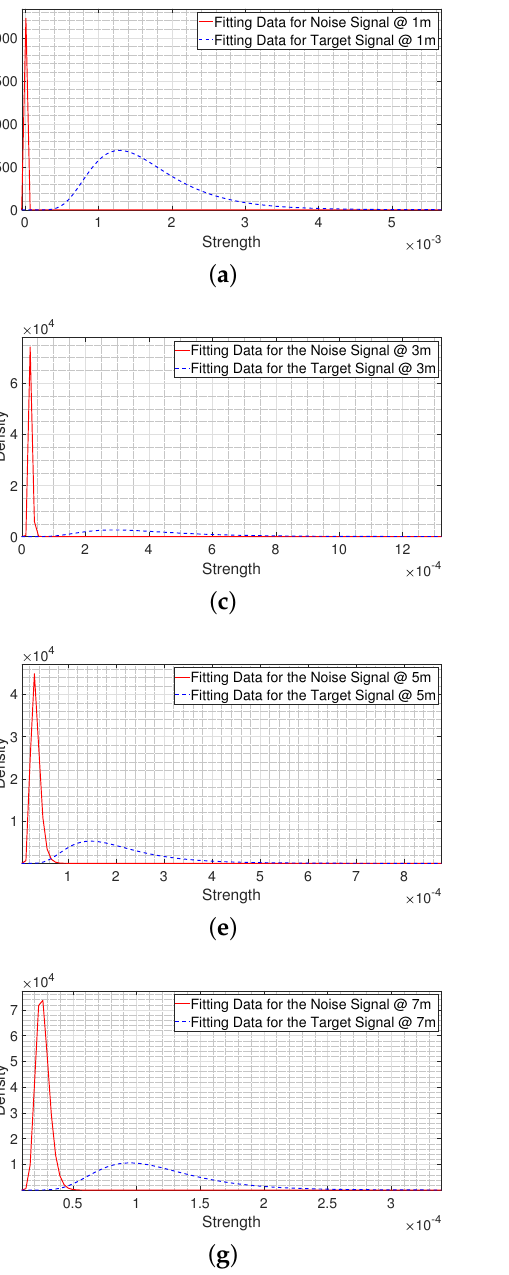
Figure 13. The fitting results from 1 m to 8 m in a light clutter environment. ( a ) The fitting result at 1 m. ( b ) The fitting result at 2 m. ( c ) The fitting result at 3 m. ( d ) The fitting result at 4 m. ( e ) The fitting result at 5 m. ( f ) The fitting result at 6 m. ( g ) The fitting result at 7 m. ( h ) The fitting result at 8